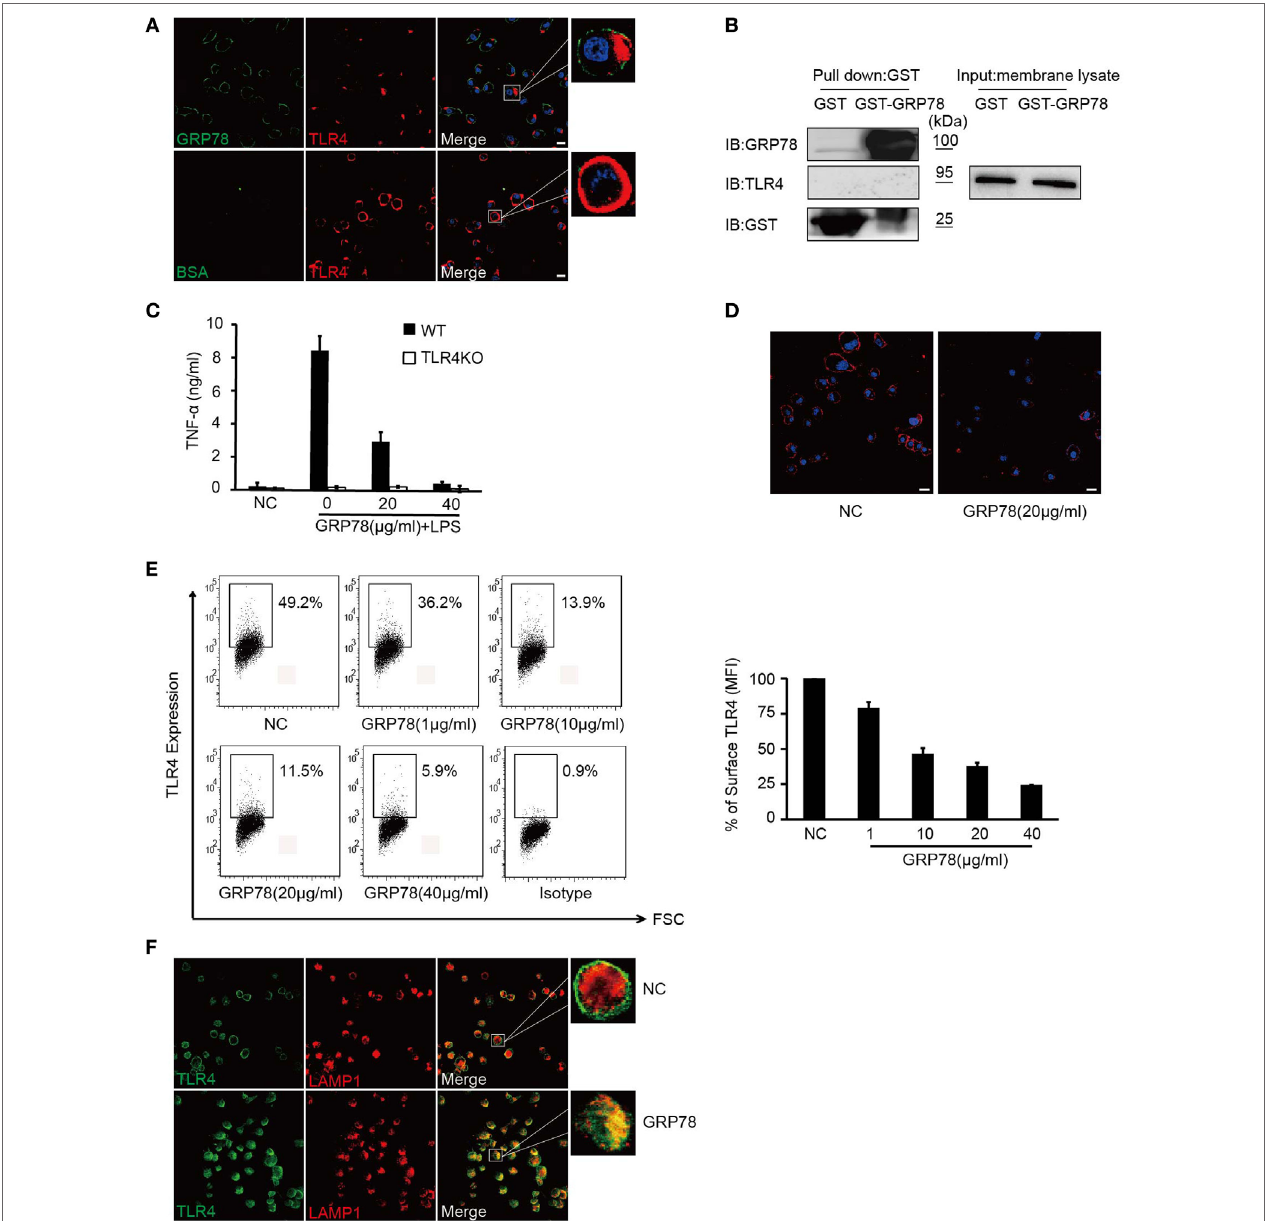
FigUre 3 | grP78 down-regulates surface levels of Tlr4 on dendritic cells . (a) DC2.4 cells were treated with AF488-GRP78 or BSA (1 µM) at 4°C for 1 h, and then TLR4 was stained using anti-TLR4 and AF555-conjugated (red) goat anti-mouse IgG. (B) Immunoblot analyses of the interaction of TLR4 with GST- GRP78, after incubation with membrane lysates of DC2.4 cells, followed by precipitation by glutathione agarose beads. (c) Enzyme-linked immunosorbent assay of TNF- α in wild-type or TLR4KO bone marrow-derived dendritic cells stimulated for 4 h by LPS together with GRP78 at the concentrations indicated. (D) DC2.4 cells were incubated with GRP78 at 37°C for 30 min, surface TLR4 was stained and detected by confocal laser scanning microscopy (CLSM). (e) DC2.4 cells were treated with GRP78 for 30 min. TLR4 surface staining was measured by FCM. Dot plots of FCM data (left) and percentage of mean fluorescence intensity (MFI, right) are depicted. Percentage of surface TLR4 (MFI) were analyzed using the following formula: (GRP78 treatment − isotype)/(NC − isotype). (F) DC2.4 cells were incubated with GRP78 at 37°C for 1 h, surface TLR4 (green) on non-permeabilized cells and intracellular TLR4 and LAPM1 (red) on permeabilized cells were stained and detected by CLSM. Error bars represent mean ± SD from triplicate samples in one experiment. All images for all panels are representative of at least three independent experiments in which > 100 cells were examined and > 95% of cells showed similar staining. Scale bar, 20